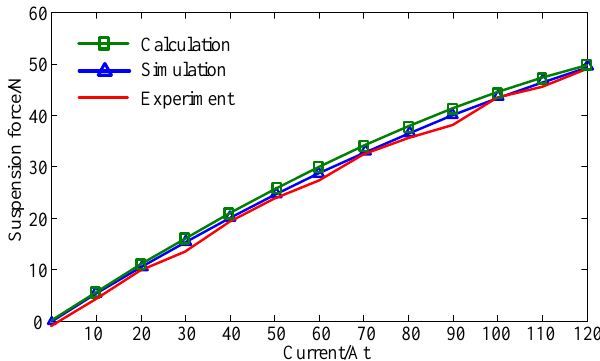
Figure 9. Comparison among calculation, simulation and experiment results.